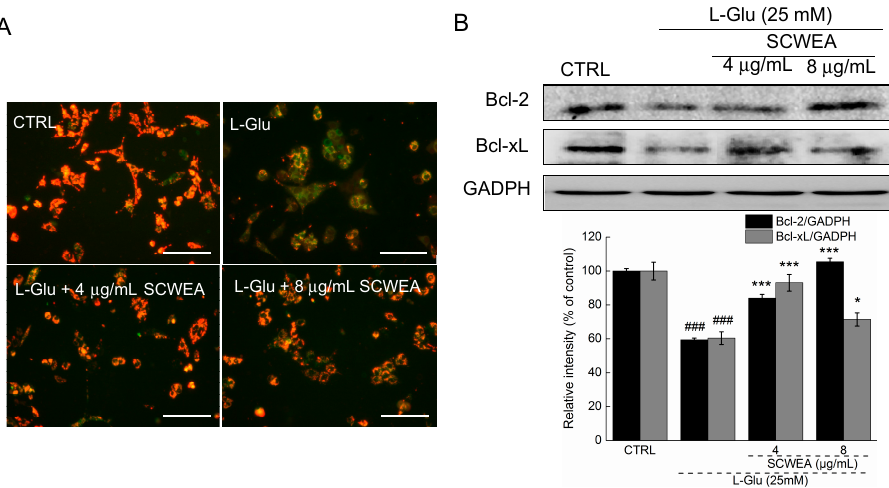
Figure 5. The positive regulatory effects of SCWEA on mitochondrial function. DPC12 cells were pretreated with 4 and 8 µg/mL SCWEA for 3 h, followed by exposure to 25 mM L -Glu for 12 or 24 h. ( A ) SCWEA restored L -Glu-induced MMP loss. The changes of MMP were determined by JC-1 staining (20×; Bar: 100 µm). Red fluorescence indicates healthy cells with high MMP, whereas green fluorescence indicates apoptotic or unhealthy cells with low MMP. The experiments were repeated three times; ( B ) SCWEA enhanced the expressions of B-cell lymphoma 2 (Bcl-2) and B-cell lymphoma-extra large (Bcl-xL) in L -Glu-exposed DPC12 cells. Quantification data were normalized by GAPDH. Data were expressed as a percentage of corresponding control cells and means ± S.D. ( n = 3). ### p < 0.001 versus control cells; * p < 0.05 and *** p < 0.001 versus L -Glu-exposed cells.